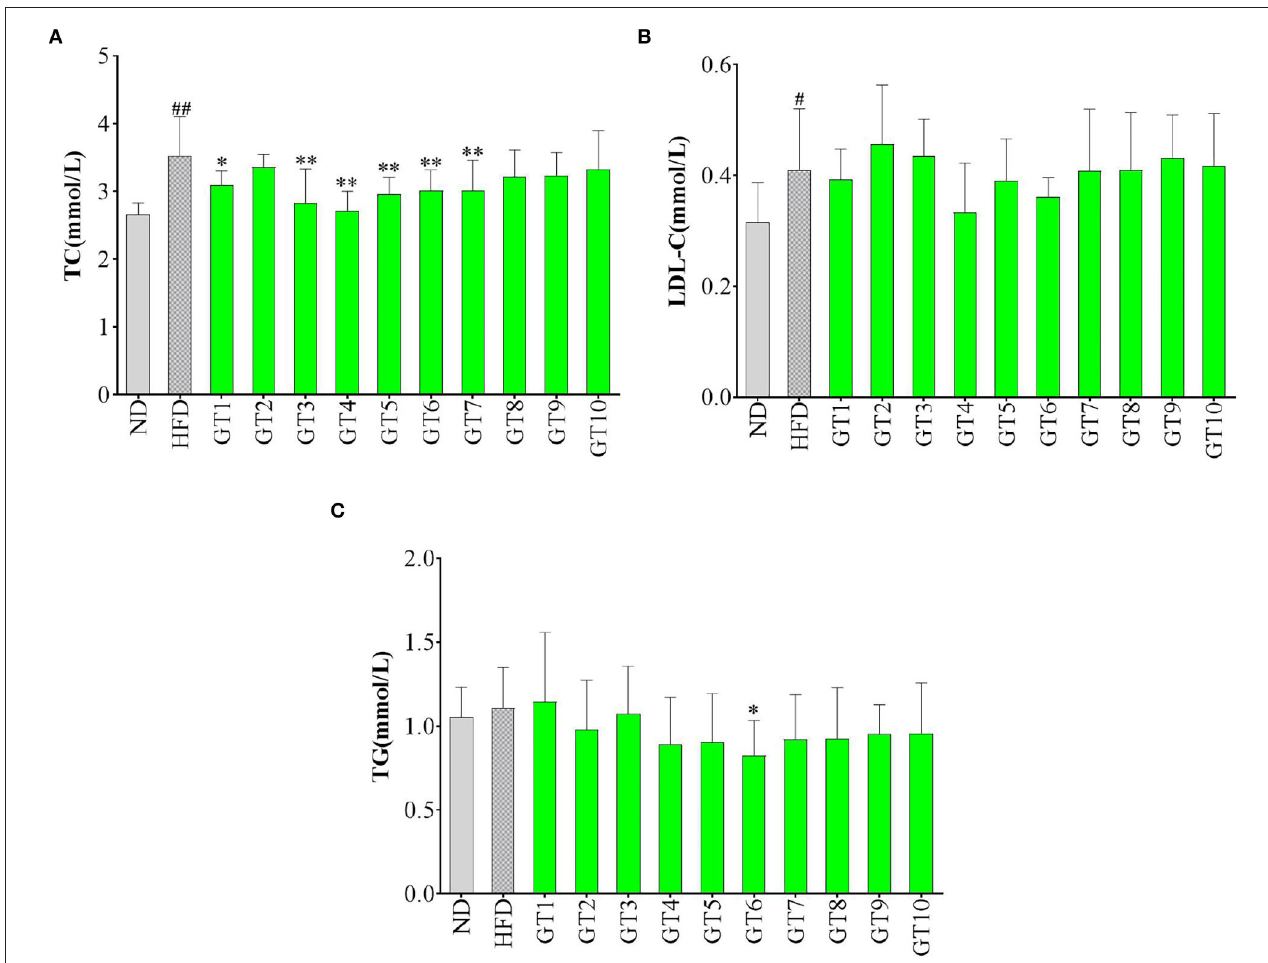
FIGURE 7 | Effects of green teas on serum lipid levels. (A) serum total cholesterol (TC) level; (B) serum low-density lipoprotein cholesterol (LDL-C) level; and (C) serum TG level. # p < 0.05, ## p < 0.01, the model group vs. the control group; * p < 0.05, ** p < 0.01, the green tea group vs. the model group. GT1, Dianqing